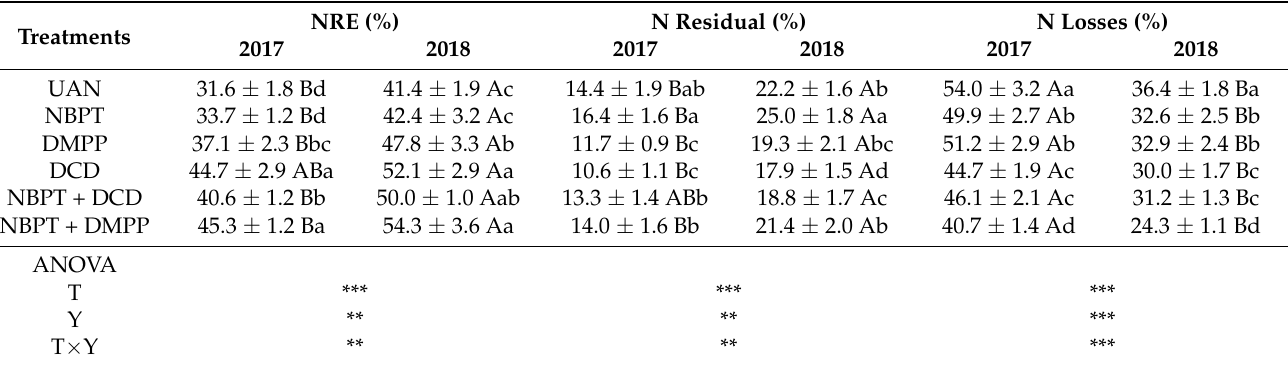
Table 3. The fate of UAN with different inhibitors in both maize growing